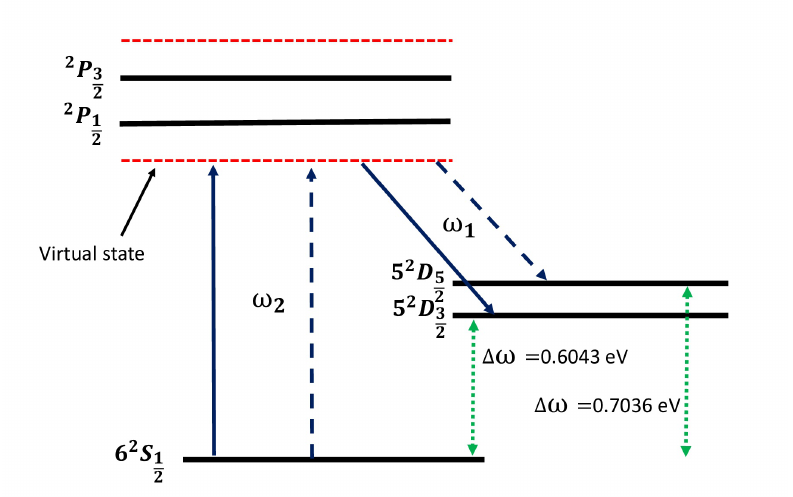
Figure 1. A schematic energy-level diagram for the ground and first few low-lying excited states (indicated by solid horizontal black line) of Ba + ion. The two-photon 6 2 S 1 − 5 2 D solid indigo arrow) and 6 2 S 1 (indicated by dotted indigo arrow) transitions are shown. The 5 2 2 red dotted lines indicate the virtual states, which can have different positions depending on the magic wavelengths. The green dotted lines with arrows in both directions indicate the frequencies of the clock